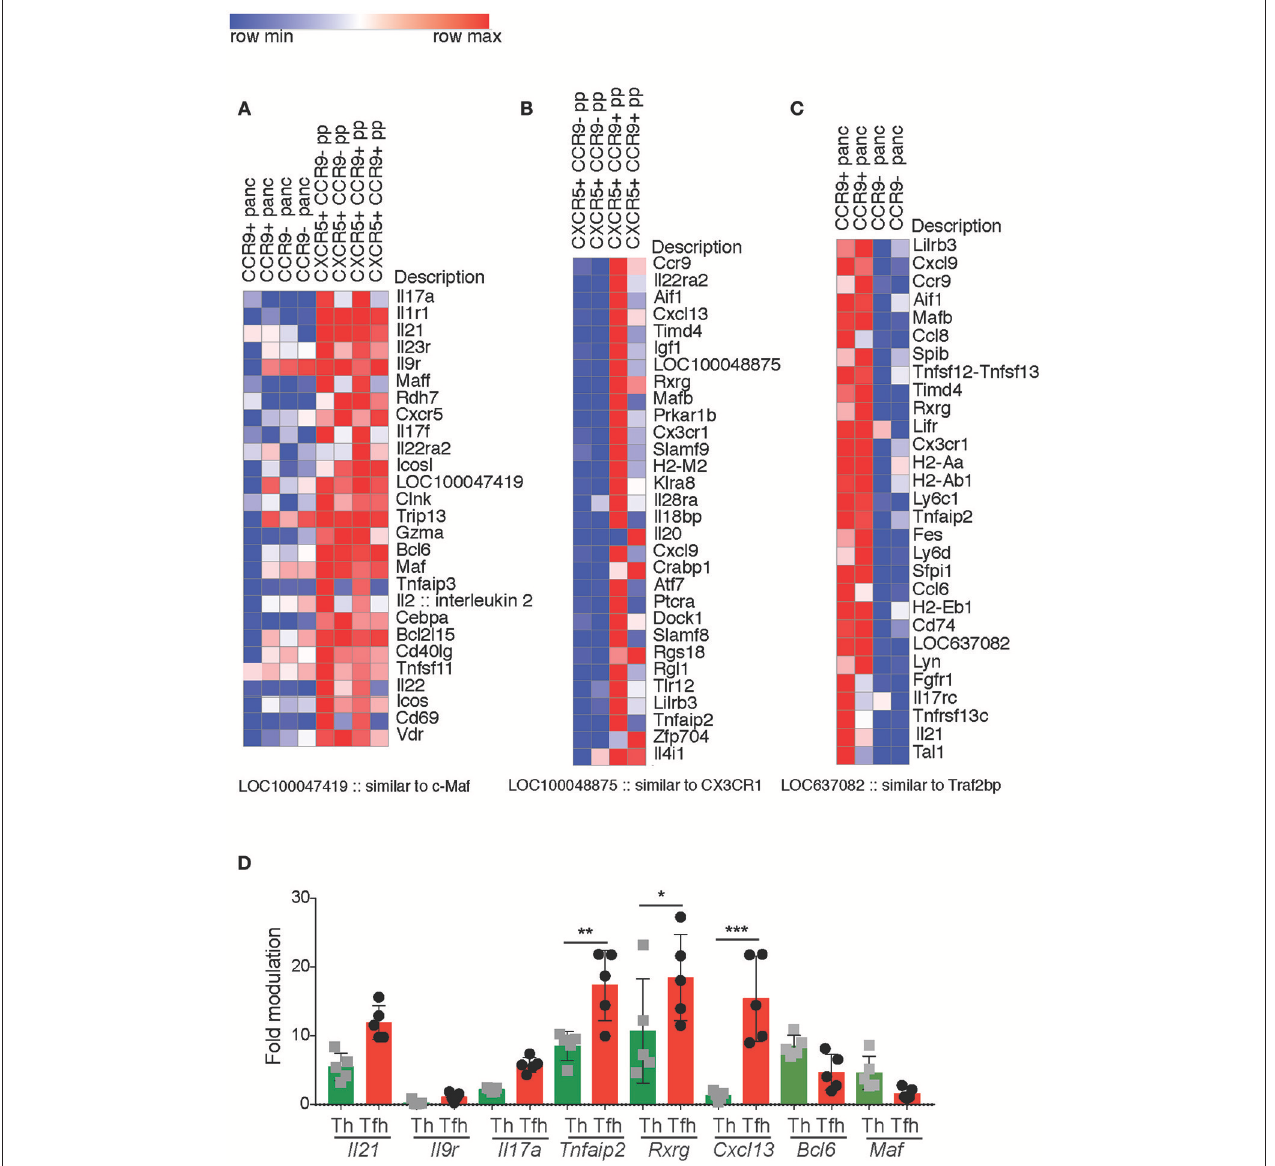
FIGURE 6 | Differentially expressed genes in CCR9 + relative to CCR9 − Tfh from the peyers patches and CCR9 + relative to CCR9 − Th cells from the pancreas infiltrate from non-obese diabetic (NOD) mice. Gene expression was determined by SurePrint G3 Mouse GE 8x60K Microarray Kit from Agilent technologies. Genes selected from the 50 most differentially expressed (DE) genes shown in heat maps, Log2 Fold difference of 2.5–5.3 (fold difference of 5.6–34.6). (A) relatively higher expression of Th17 signature genes in CCR9 + T follicular helper (Tfh) cells from the Peyers patches compared with CCR9 + T helper (Th) cells from the pancreas of 10–12 week old female NOD mice. (B) DE genes from Peyers patch CCR9 + Tfh cells relative to Peyers patch CCR9 − Tfh cells. (C) DE genes from CCR9 + Th cells relative to CCR9 − Th cells from the pancreas infiltrate of 12 week old female NOD mice. (D) qPCR validation of DE genes selected from (A–C) . Gene expression of Il21, Il9r, Il17a, Tnfaip2, Rxrg, and Cxcl13 from CCR9 + Tfh or Th cells analyzed by real-time PCR relative to Rpl19 expression. Data are shown as fold modulation of gene expression in CCR9 + Tfh relative to CCR9 − Tfh cells or CCR9 + Th cells relative to CCR9 − Th cells, where n = 5 mice per group. Statistical significance was assessed by 2-way ANOVA using Bonferroni’s multiple comparisons test. * P < 0.05; ** P < 0.01; *** P < 0.001.